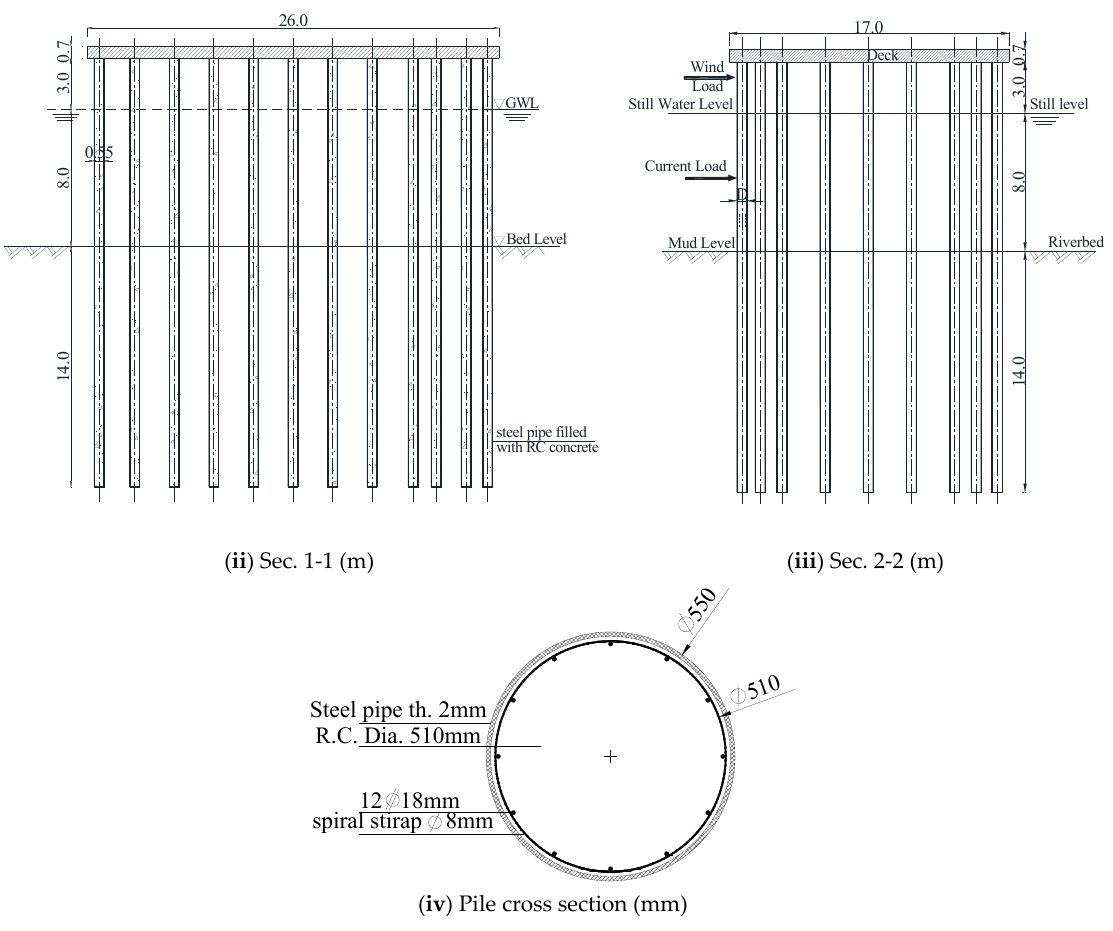
Figure 2. The platform plan and sections.